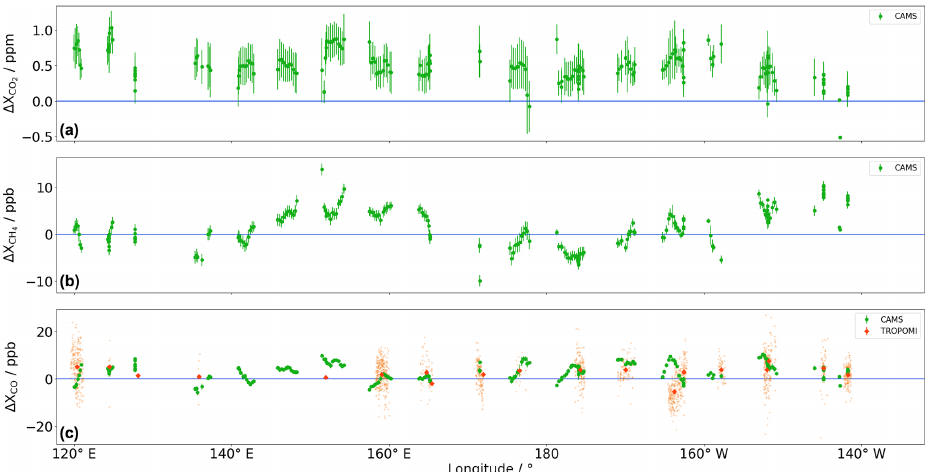
Figure 6. Differences between CAMS and our shipborne EM27/SUN (green) for XCO 2 (a) , XCH 4 (b) , and XCO (c) and between TROPOMI XCO and our EM27/SUN (orange). The EM27/SUN measurements were subtracted from the CAMS data and coincident TROPOMI obser- vations.